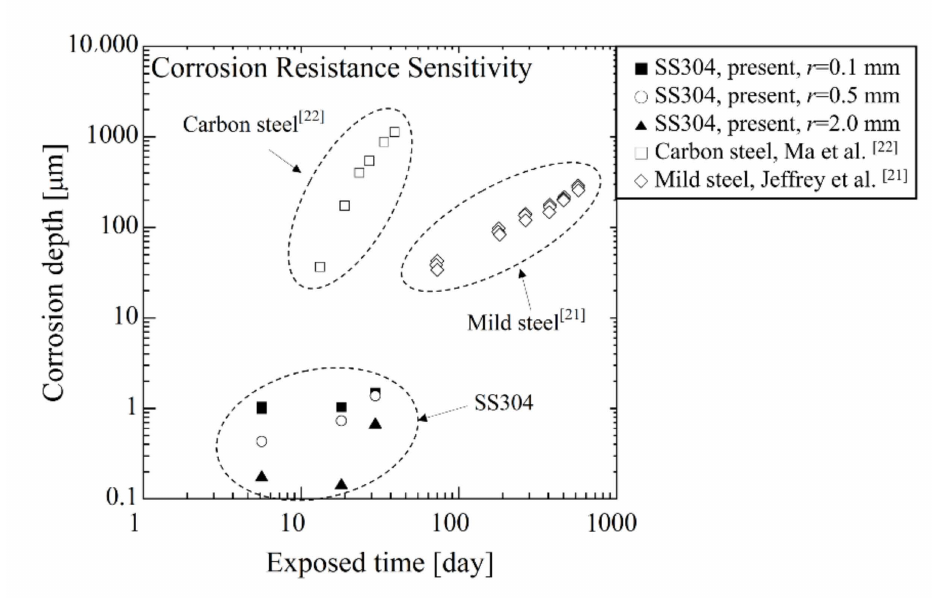
Figure 9. Comparison of the corrosion depth and the exposure time for various materials under marine environments [21,22]. The figure is shown in the log-log scale.